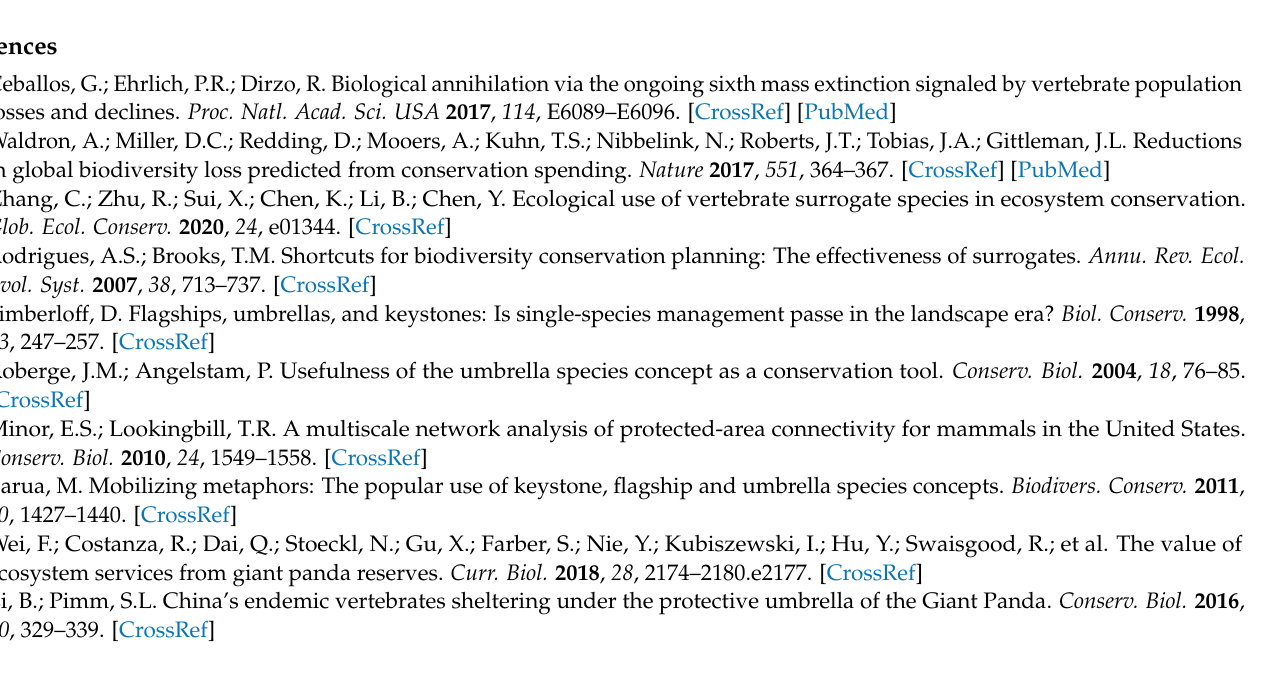
Table S2: Detailed biological features and conservation status of the 213 recommended umbrella species of terrestrial